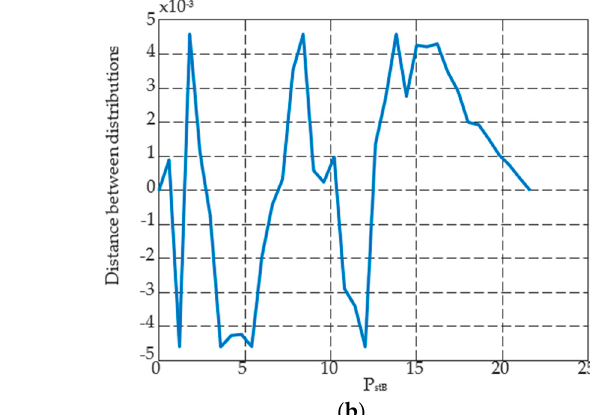
Table 3. The values characterizing the density distributions for points A and B. k